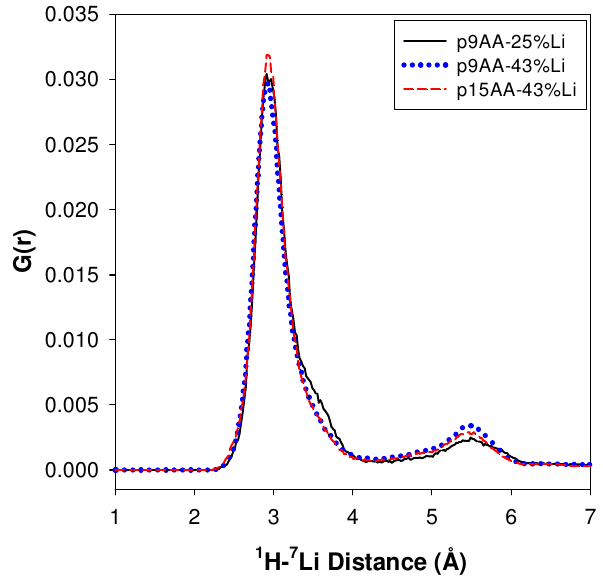
Figure 6. 1 H- 7 Li pair correlation functions for different P(E-AA) ionomers predicted from molecular dynamics (MD) simulations (423 K).